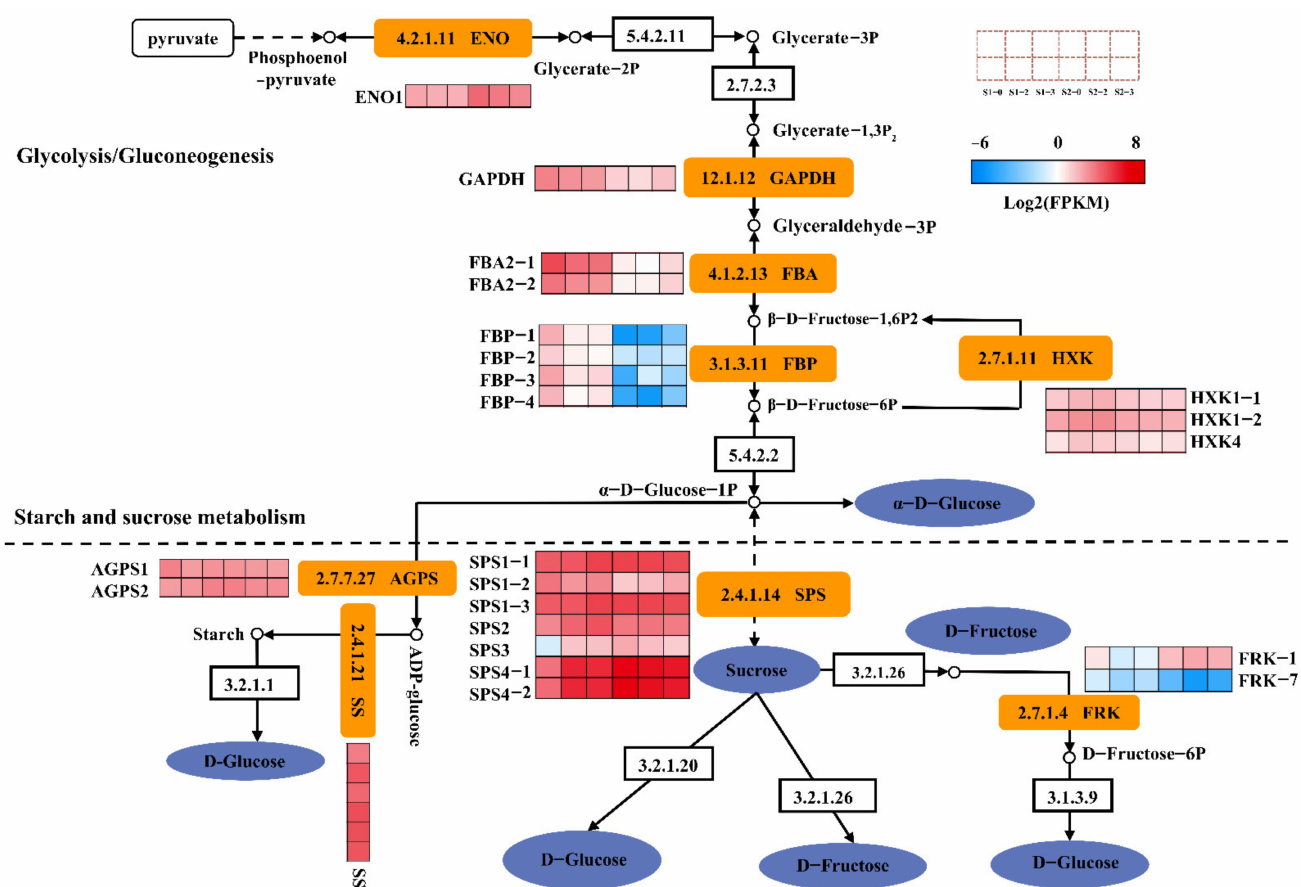
Figure 6. Regulation of sugar metabolism pathways in different nitrogen levels. The expression of DEGs is represented by Log2(FPKM). The color from blue to red represents the expression value from low to